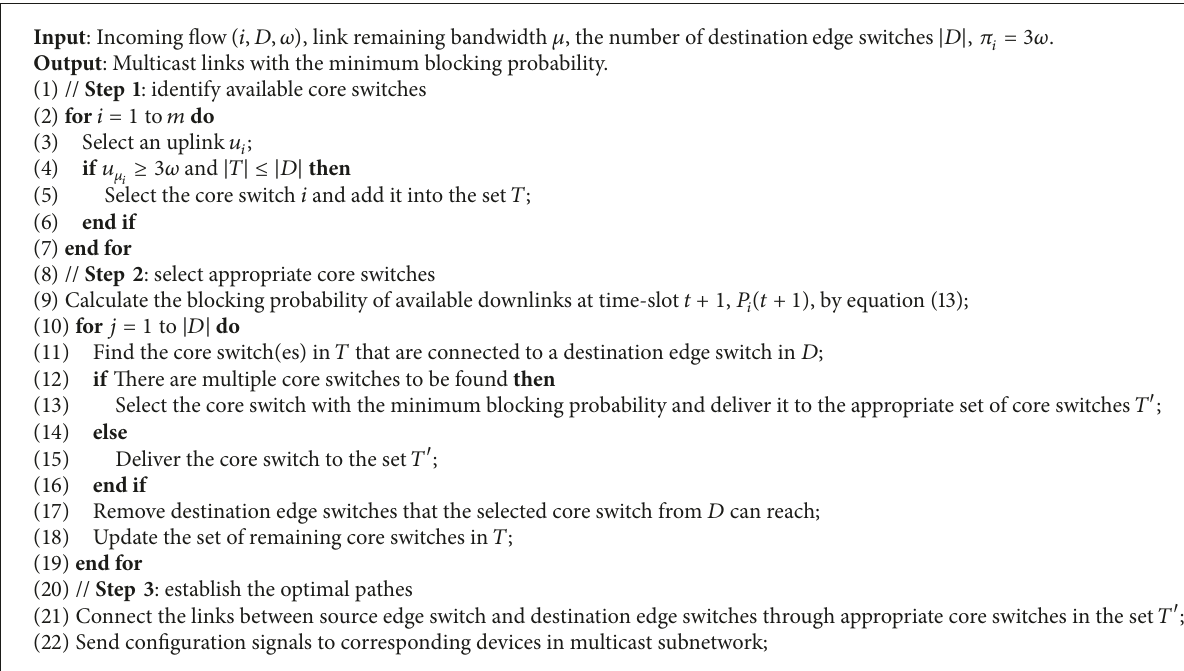
Algorithm 1: Multicast scheduling algorithm with Markov chains (MSaMC).